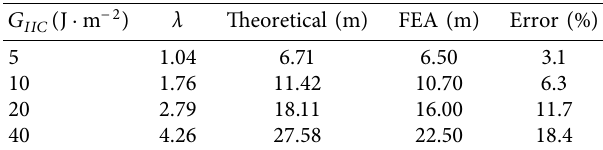
Table 2: Comparison of the theoretical and simulated L 0 for various G IIC